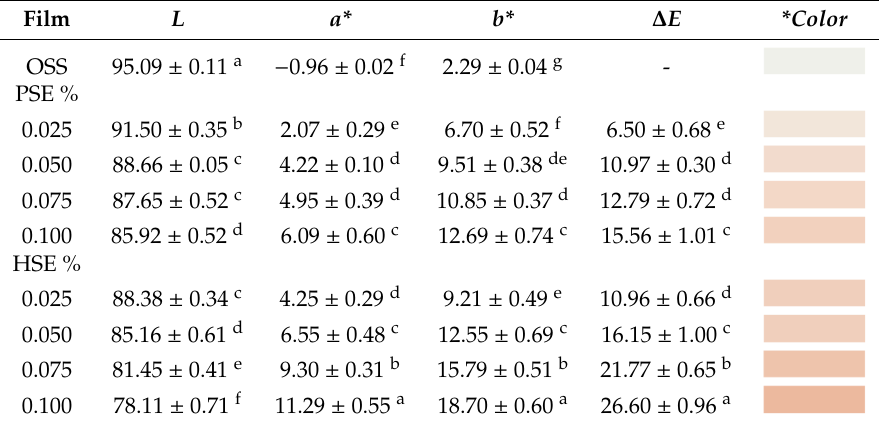
Table 4. Color parameters ( L* , a* , b*, and ∆ E ) of octenyl succinate starch films.